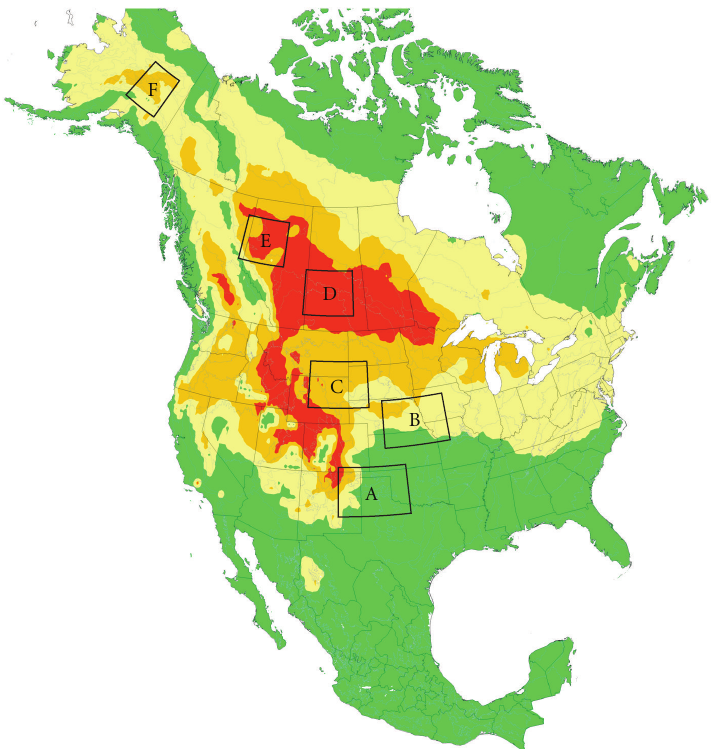
Figure 3: Predicted distribution and abundance (EI) of Melanoplus sanguinipes for 2080 (MIROC-H) at six regions: (A) Lubbock, TX; (B) Lincoln, NE; (C) Gillette, WY; (D) Saskatoon, SK; (E) Peace River, AB; (F) Fairbanks, AK. Green = “Unfavourable” (EI = 0 − 5); Tan = “Suitable” (EI = 5 − 20); Orange = “Favourable” (EI = 20 − 30); Red = “Very Favourable” (EI ≥